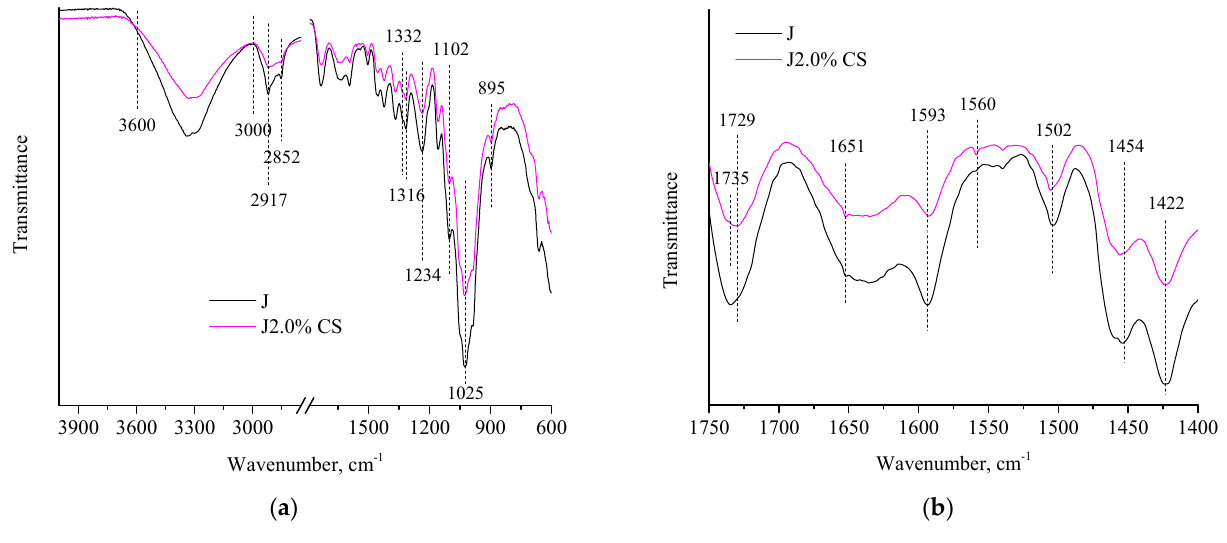
Figure 3. ATR-FTIR spectra of selected fabrics in the range: ( a ) 4000–600 cm − 1 and ( b ) 1750–1400 cm − 1 .